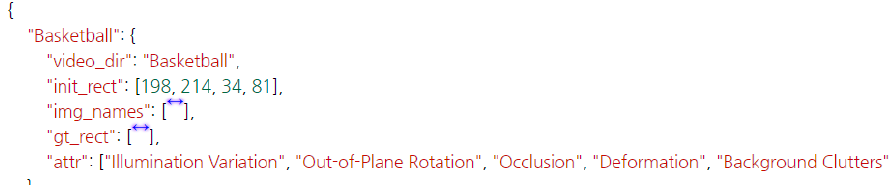
Figure 10. Annotation Format of OTB Dataset.